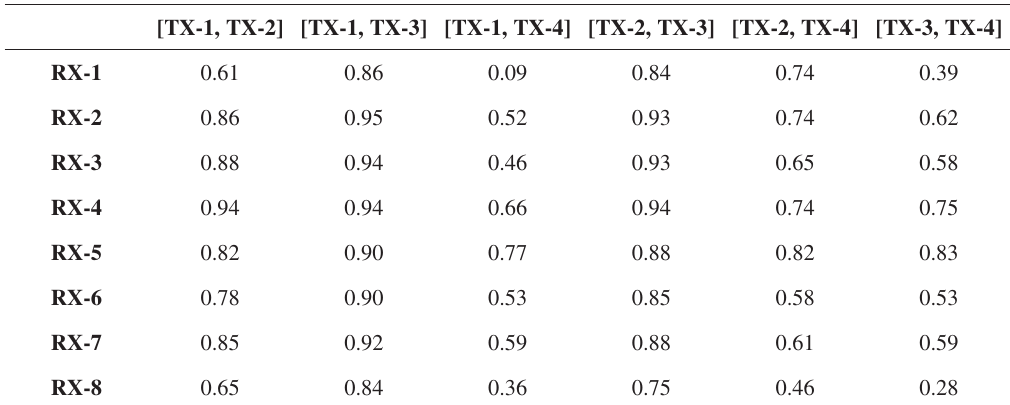
Table I. Amplitude correlation coefficients between the various transmissions from Durham at each receiving antenna of the heterogeneous circular antenna array in Monterfil for a period of approximately one minute at 10:20 UT on 3 July 2008 [TX-1: N-S inverted ‘V’ crossed-wire (5.795010 MHz), TX-2: E-W inverted ‘V’ crossed-wire (5.795020 MHz), TX-3: loop (5.795030 MHz), TX-4: vertical whip (5.795040 MHz)].